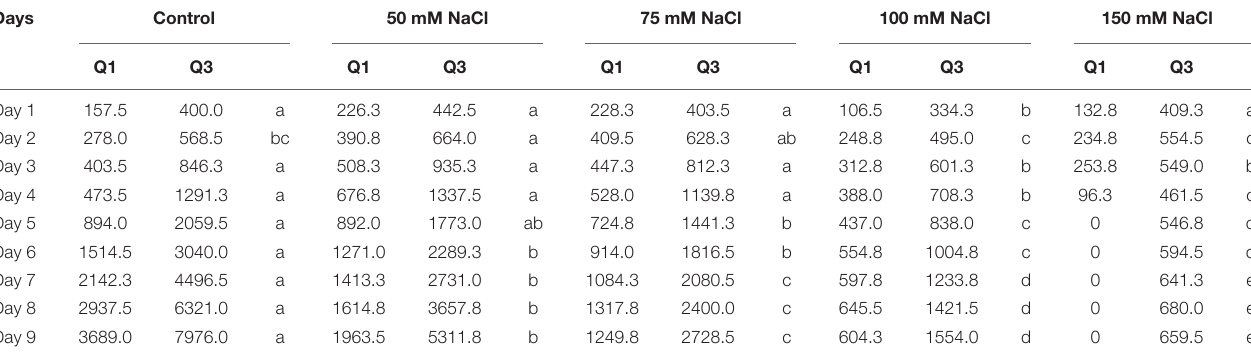
TABLE 2 | The effect of salinity on Arabidopsis rosette